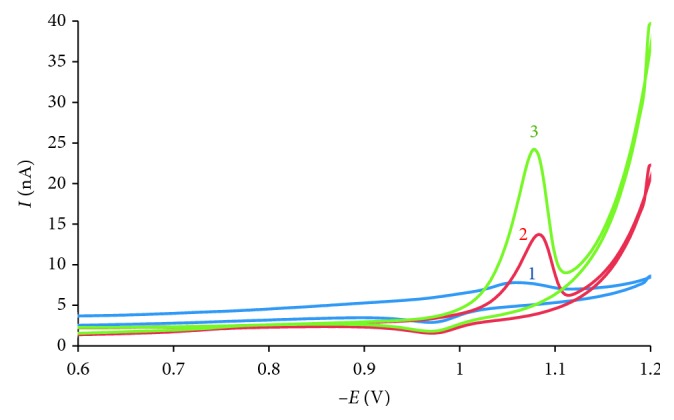
Cyclic voltammogram at scan rate 50 mV·s−1 and Eacc = 0 V of (1) blank sample (pH = 5.0, tacc = 0 s); (2) 10−6 mol·L−1 AO solution (pH = 5.0, tacc = 0 s); (3) 10−6 mol·L−1 AO solution (pH = 5.0, tacc = 30 s).